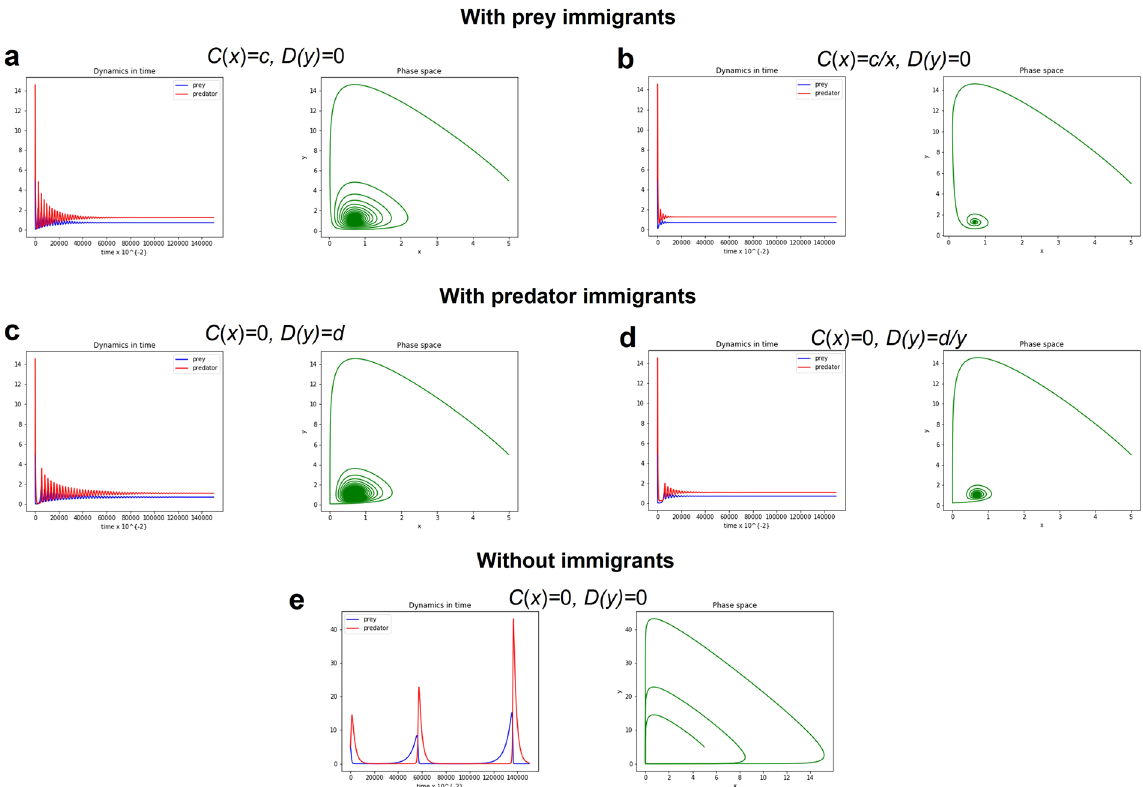
Figure 3. Phase space and long-term population dynamics of the predator-prey population described by LV system (4) with type II functional response and with/without small immigrants. Four cases of the modified LV system (4) with small immigration is compared to LV system (4) without small immigrants. Parameter values: Initial x = 5, Initial y = 5, r = 0.1, a = 0.1, b = 0.3, m = 0.2, c = 0.01, d = 0.01 and h =